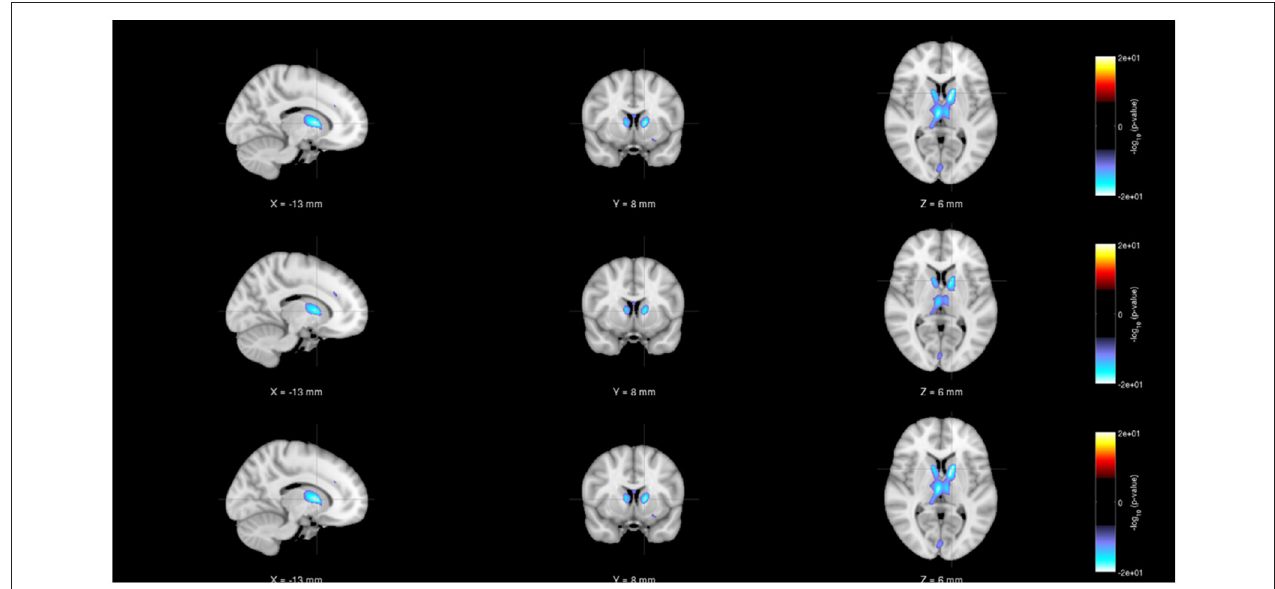
FIGURE 6 | Rendered images of voxel-wise significance values ( − log 10 p -value × sign( t )) for the covariate “Gender” from pooled regression (Top) and single-shot regression (Center) and multi-shot regression (Bottom) overlaid on MNI average template. It can be seen from all the three rendered images that there is a significant amount of gray matter reduction in the sub-cortical regions for males. Since we are using unmodulated gray matter maps, these sex differences could be due to changes in brain volumes.